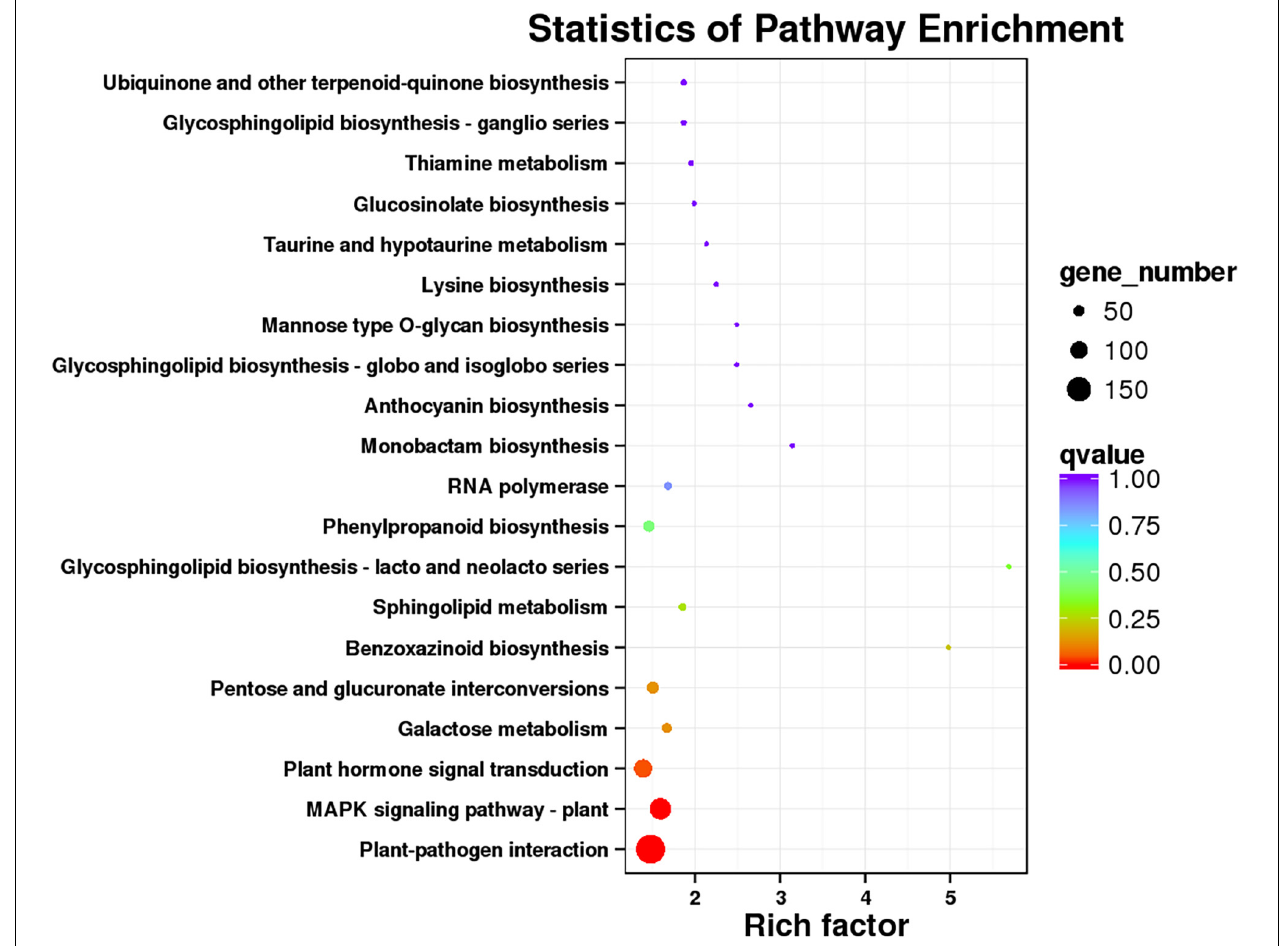
FIGURE 6 | KEGG pathways of DEGs of 62\3 and JB231AC under 50 µ M Cd